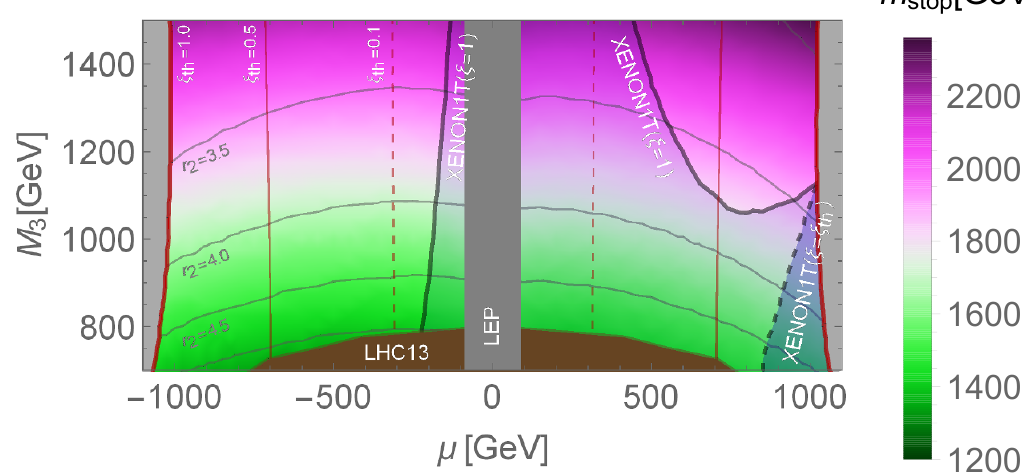
Figure 4 . Values of the dark matter observables with M 1 = 10 TeV. Meanings of lines and regions are same as in (cid:12)gure 2. In addition, the dark brown region is excluded by the gluino search at the